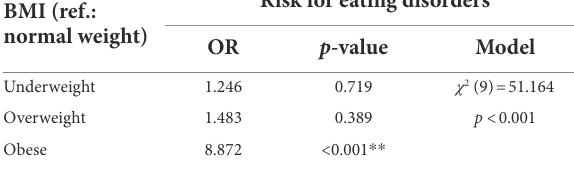
TABLE 4 Adjusted odds ratios for risk for eating disorders by BMI